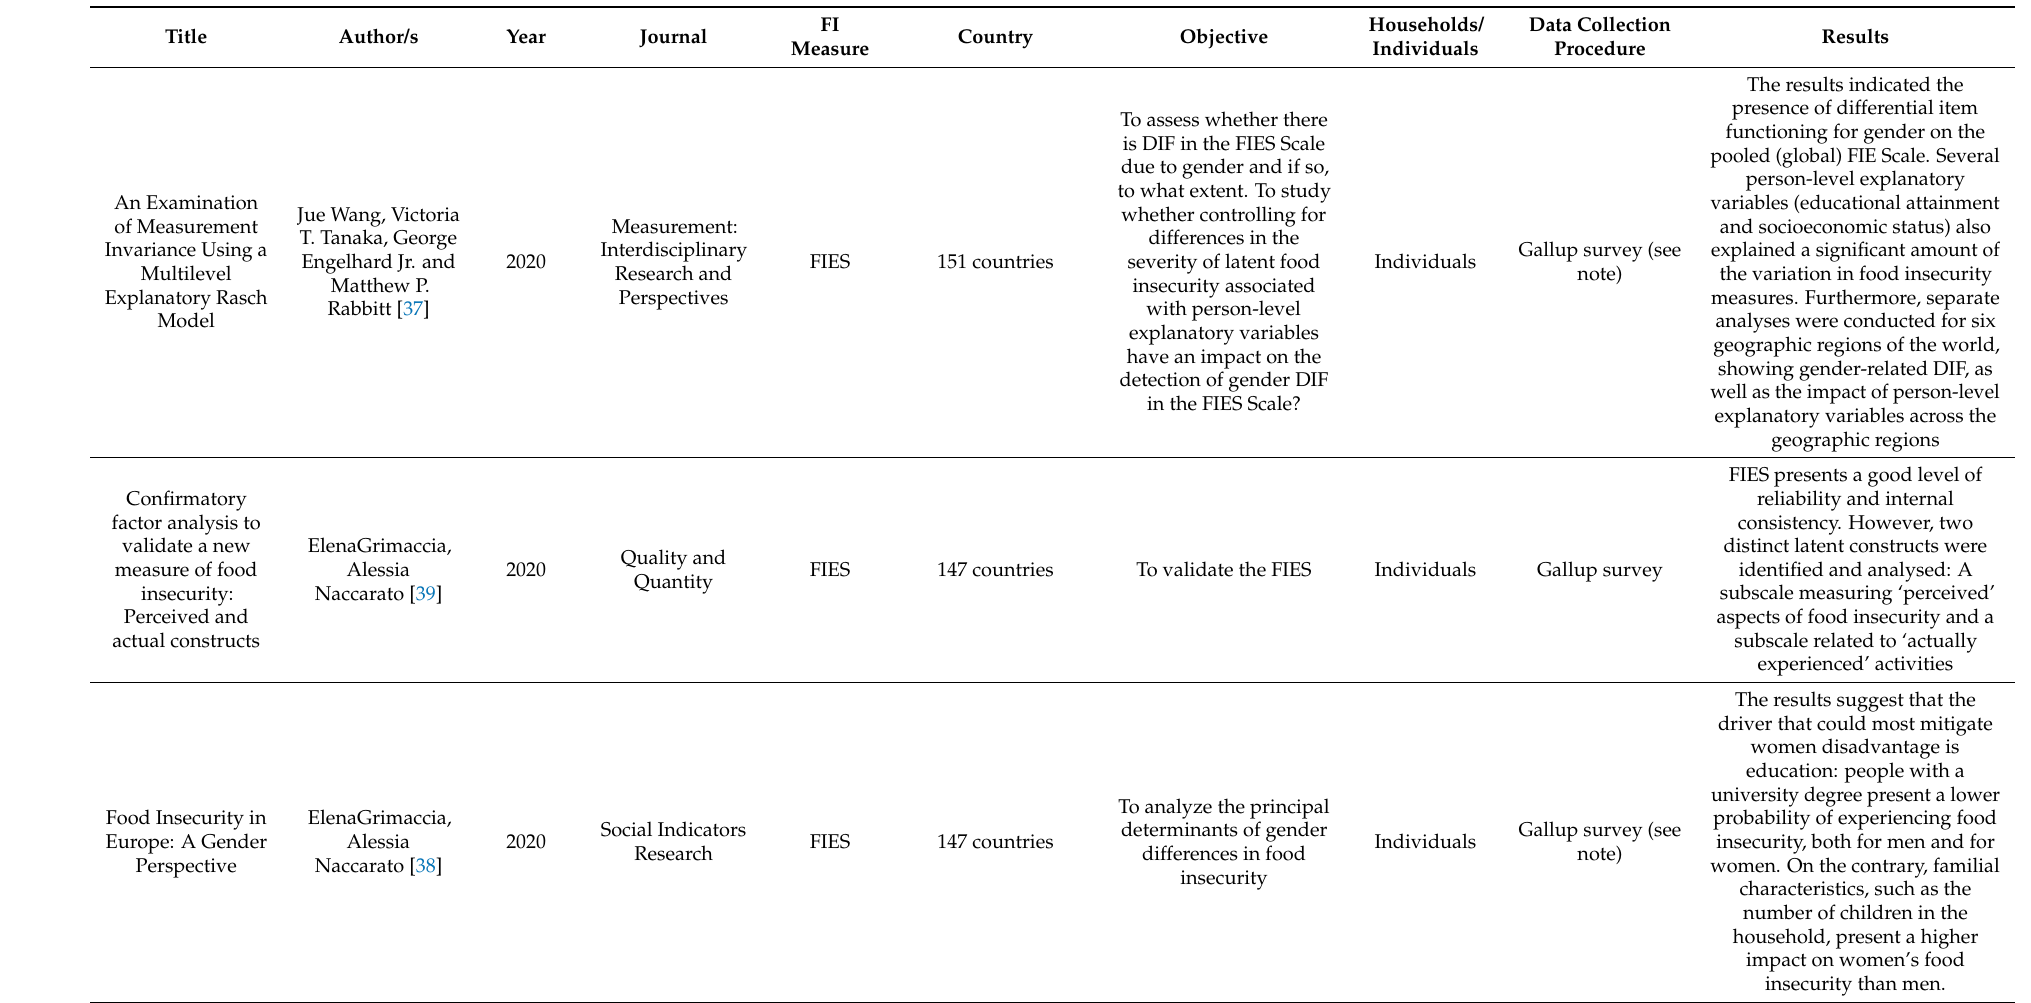
Table 1. Overview of scientific literature of food insecurity studies: original articles and literature